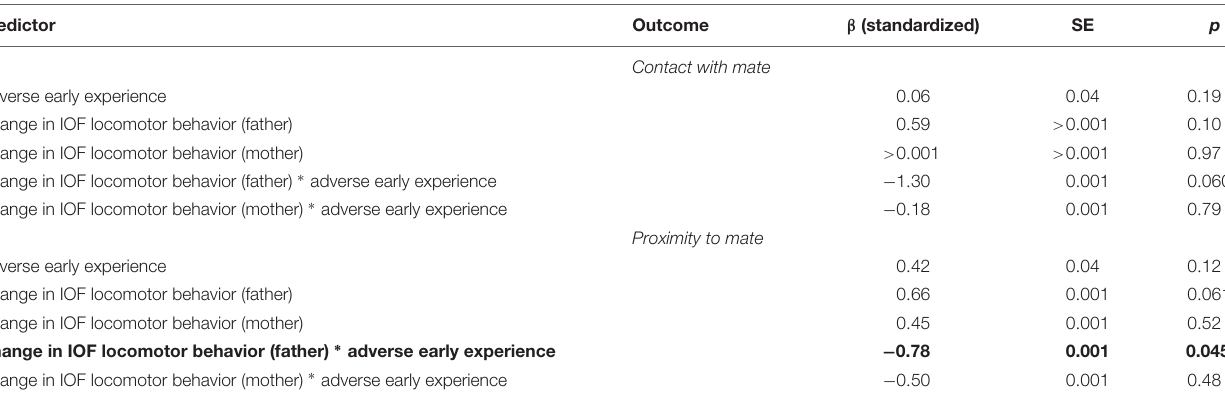
TABLE 6 | Summary of results for Experiment